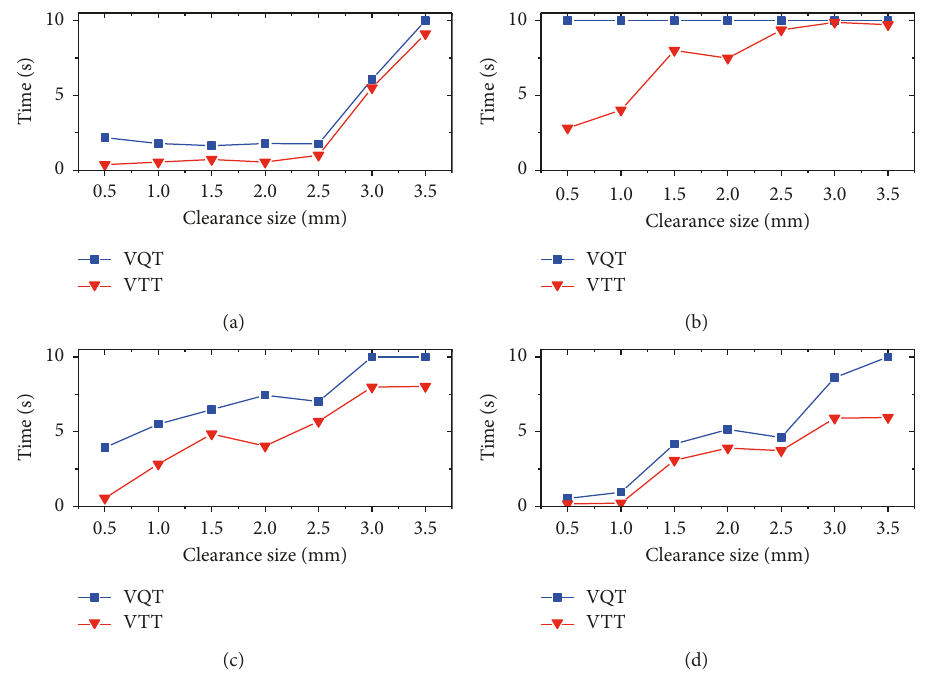
Figure 16: Vibration quit time and vibration total time based on an analysis of the velocity of rod 2 with different F (b) F max � 8kN; (c) F max � 12 kN; (d) F max � 16